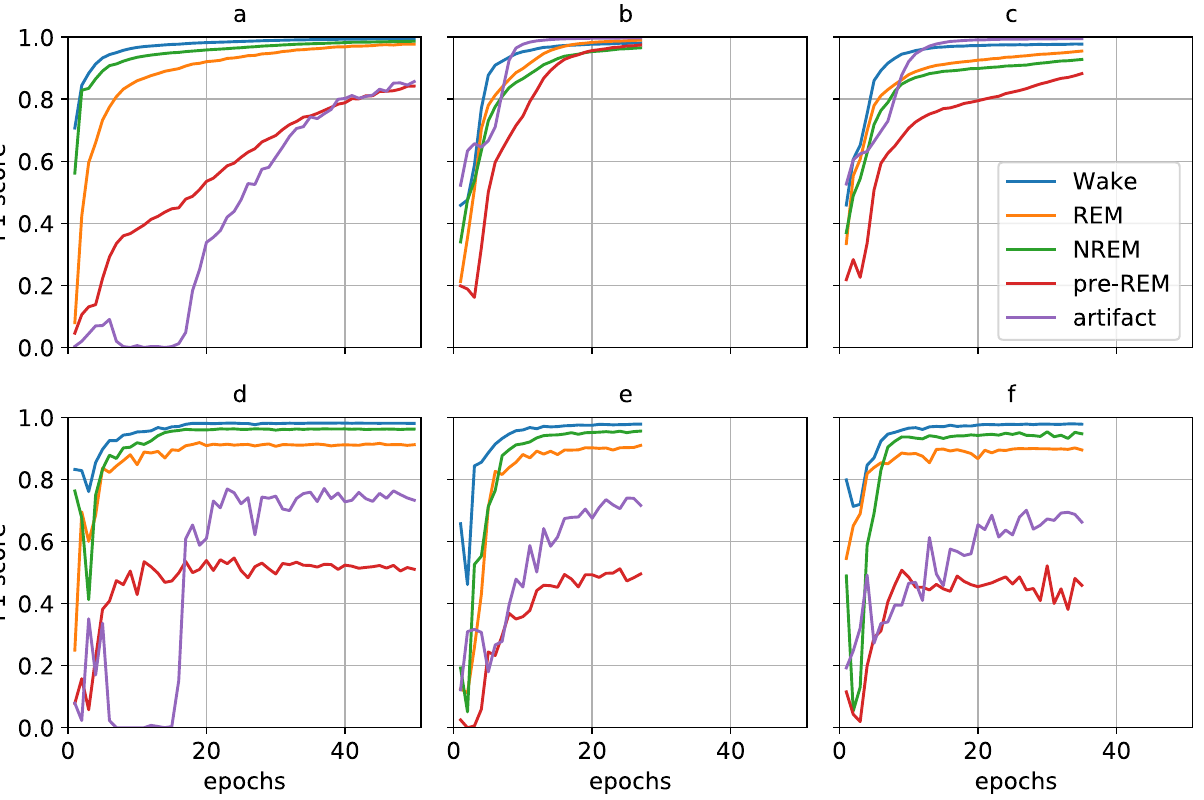
Figure 3. Evolution of F1 scores during training determined on the training set (top row) and validation set (bottom row). The evolution of F1 scores changed depending on whether the network was trained on unbalanced training data (panels a and d ), rebalanced training data #1 (panels b and e ), or rebalanced training data #1 with time shift augmentation (panels c and f